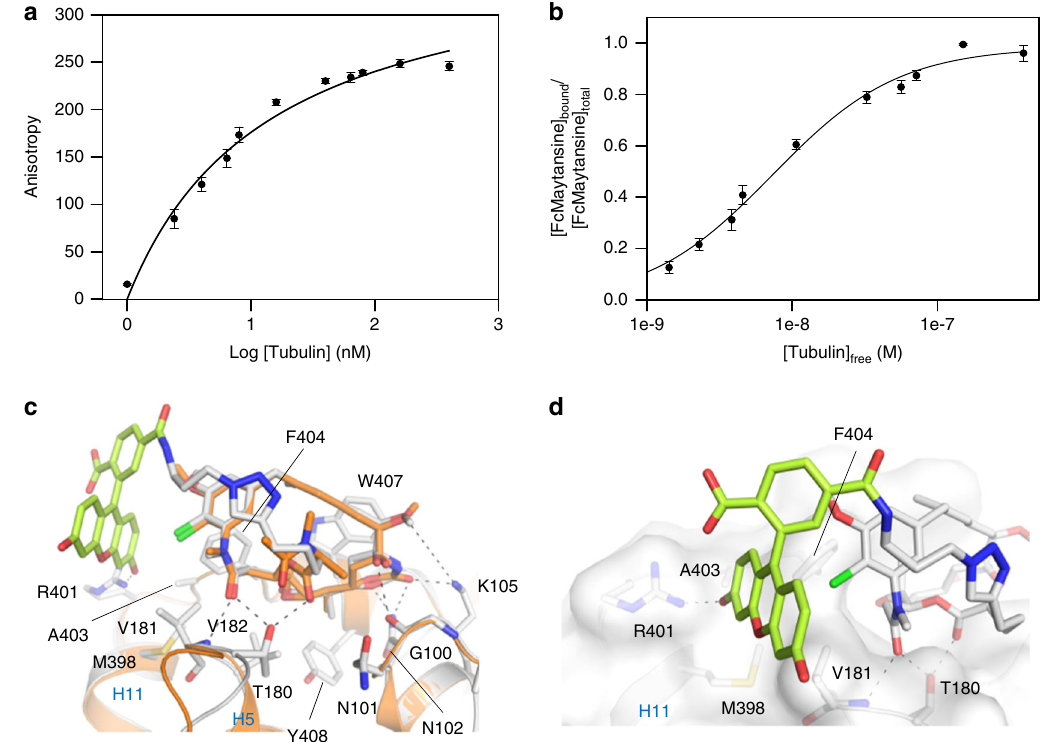
Fig. 2 Binding of FcMaytansine to tubulin. a , b FcMaytansine (10 nM) anisotropy variation ( a ) and fraction bound ( b ) as a function of the tubulin concentration. The data are from three independent experiments and represent mean ± SEM. The solid lines represent fi ts to the data (see Methods). c Crystal structure of the tubulin – FcMaytansine complex. Superposition of FcMaytansine (white/green) and maytansine (orange, PDB ID 4TV8) bound to tubulin. The superimposed β -tubulin chains are in ribbon, both the ligands and the interacting residues are in stick representation and are labeled. d Close- up view of the interactions formed by the xanthene-moiety of FcMaytansine. The same display settings as in c are